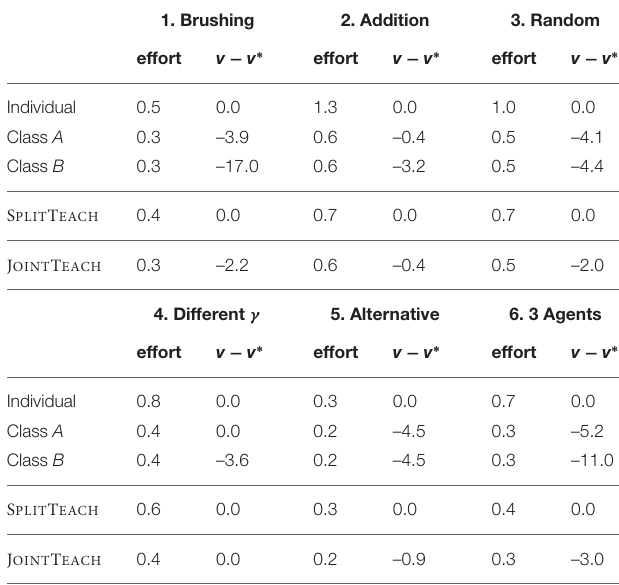
TABLE 2 | Results for class teaching in five different Markov decision problems